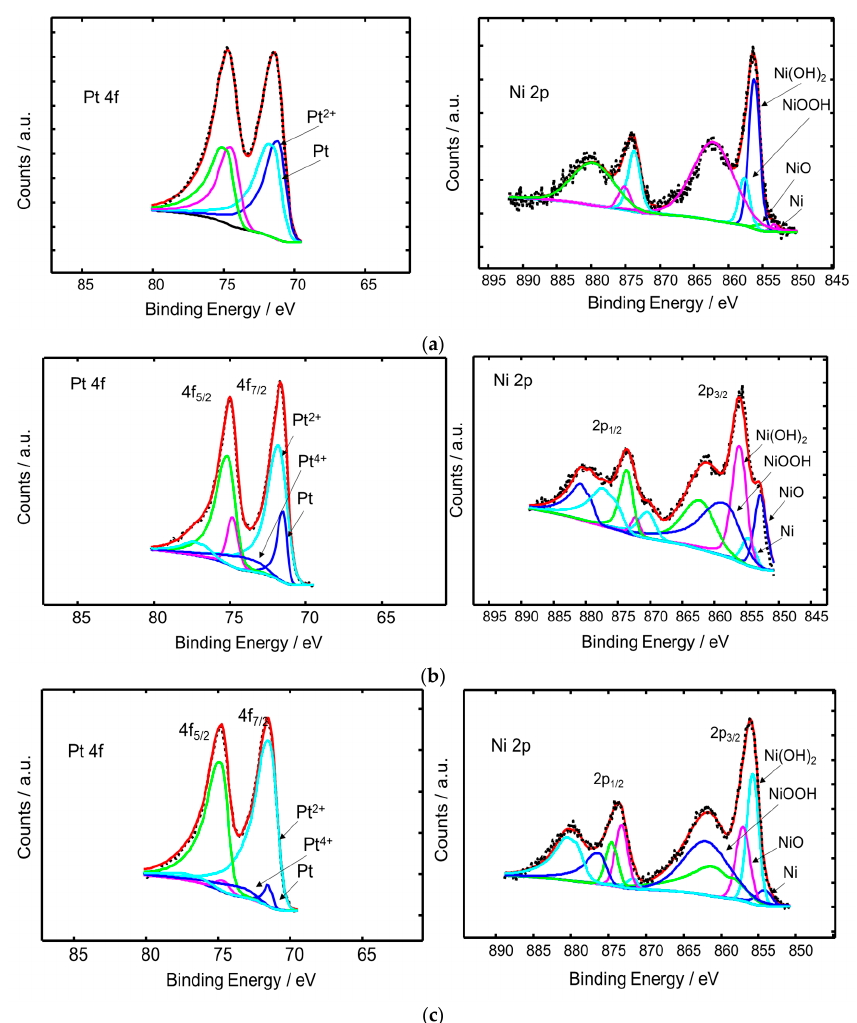
Figure 3. XPS spectra of Pt 4f and Ni 2p signals for carbon supported ( a ) Pt 1 Ni 1 ; ( b ) Pt 3 Ni 2 ; and ( c ) Pt 2 Ni 3 catalysts after the thermal and leaching treatments.